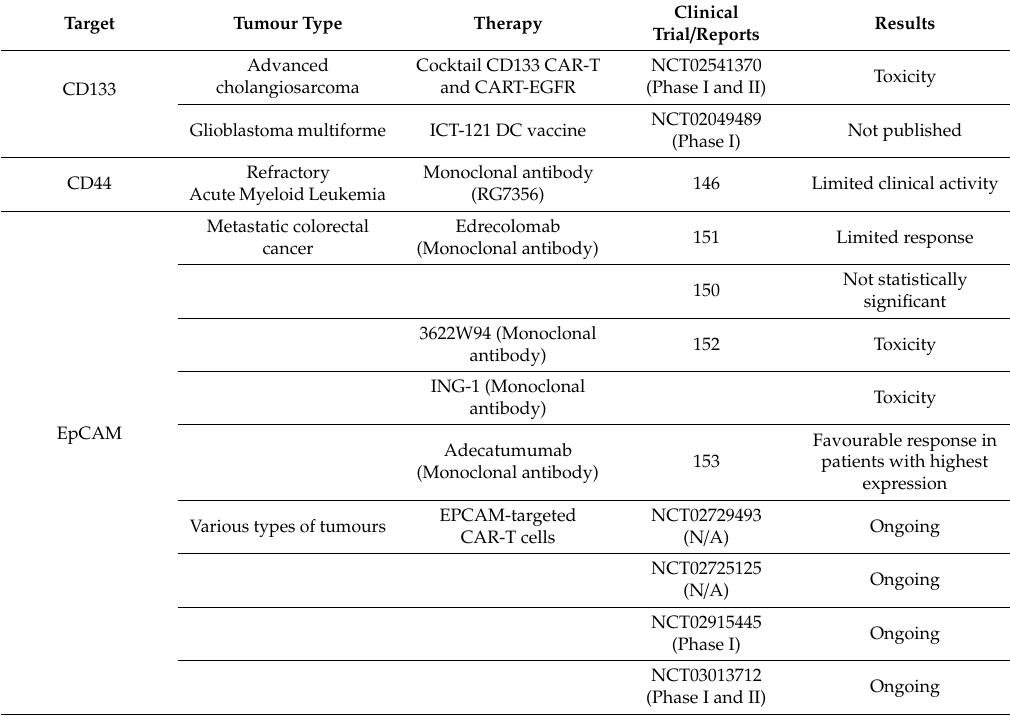
Table 2. Clinically tested strategies that were employed to target CSCs. Two main therapies were used: monoclonal antibodies therapies and dendritic cells-based